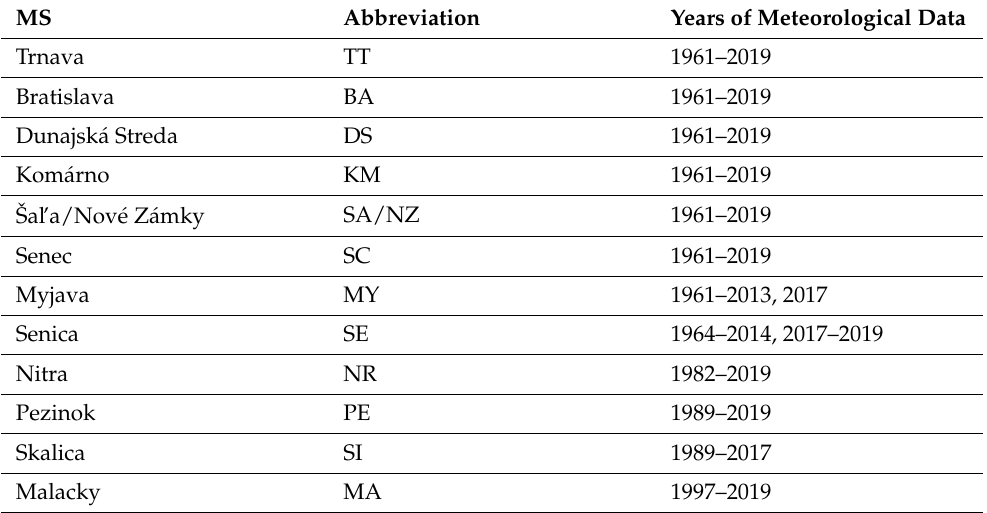
Table 1. List of meteorological stations and years of data